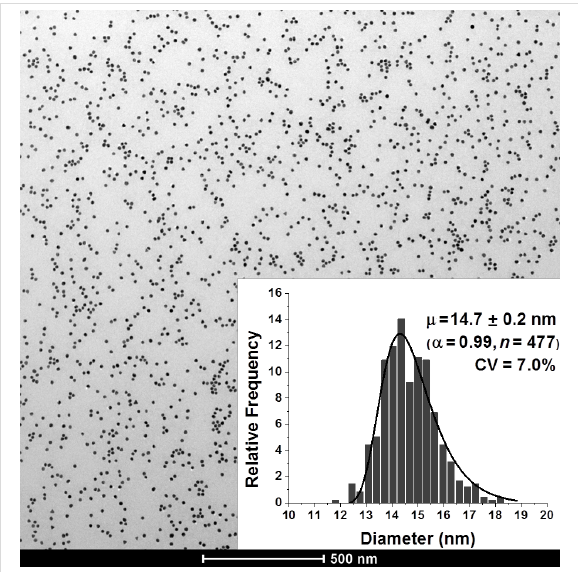
Figure 3: TEM micrograph and dimensional dispersion histogram (inset) of AuNP-SA-BiotinDNA.